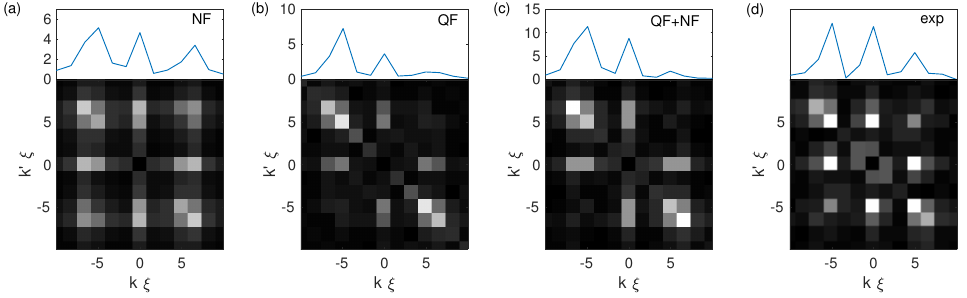
Figure 4: 2D wavevector spectra for the correlations in Fig. 3 by (a) number fluctuations, (b) quantum fluctuations, and (c) both. Bottom: 2D wavevector spectrum; top: cut-through of the 2D spectrum at k (cid:48) ξ = 5 (note different scales on the plots). Panel (d): the experimental wavevector spectrum calculated from the digitized correlation data in Fig. 3(d); upper panel is its cut-through at k (cid:48) ξ = 5. Note that for panels (a) and (c), the number of condensate atoms fluctuates about ∆ N / ¯ N = 0.05. For all the 2D spectra, the value at k = k (cid:48) = 0 is calibrated to zero, which corresponds to a constant shift of the correlation